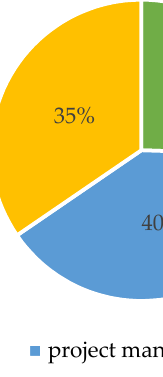
Figure 1. Occupational distribution map of 55 respondents.